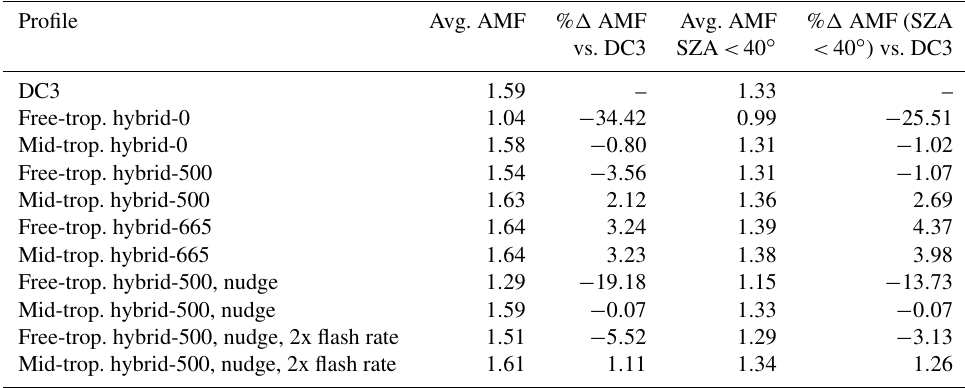
Table 2. Results of the AMF sensitivity tests on the hybrid profiles in Fig. 5. Profile Avg. AMF % (cid:49) AMF Avg. AMF % (cid:49) AMF (SZA vs. DC3 SZA < 40